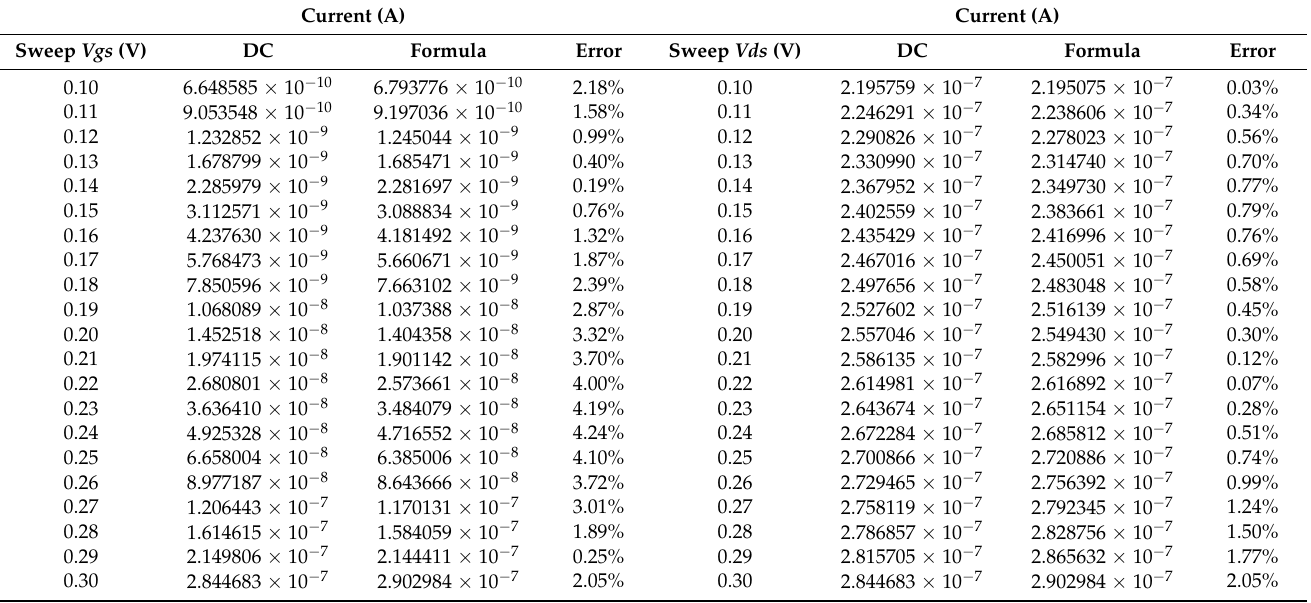
Table A2. Size 1: Current data compared with simulation